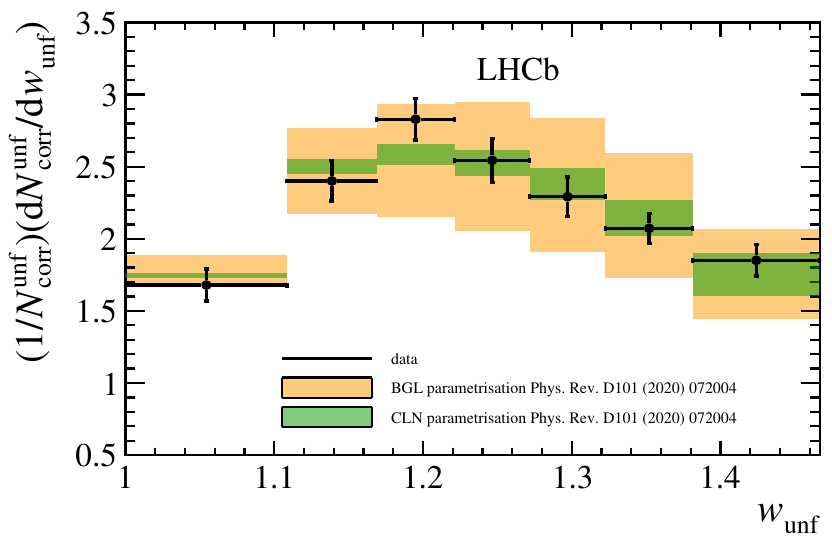
Figure 9 . Comparison between the w spectrum measured in this paper to the normalised ∆Γ / ∆ w spectra inferred from the CLN and BGL parametrisations in ref.